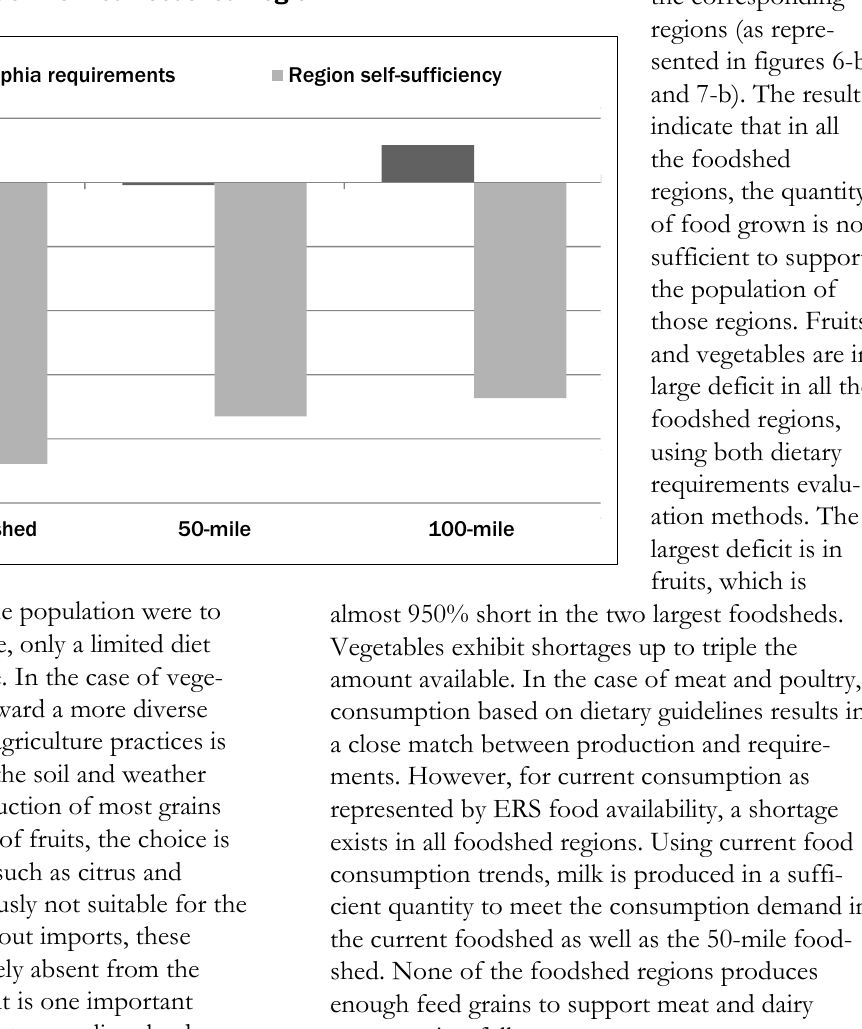
Figure 8. The Regional Capacity To Support Animal Grain Feed Production for Consumption of Meat, Poultry, Eggs, and Milk by the Philadelphia Population and the Entire Population of Each Defined Foodshed